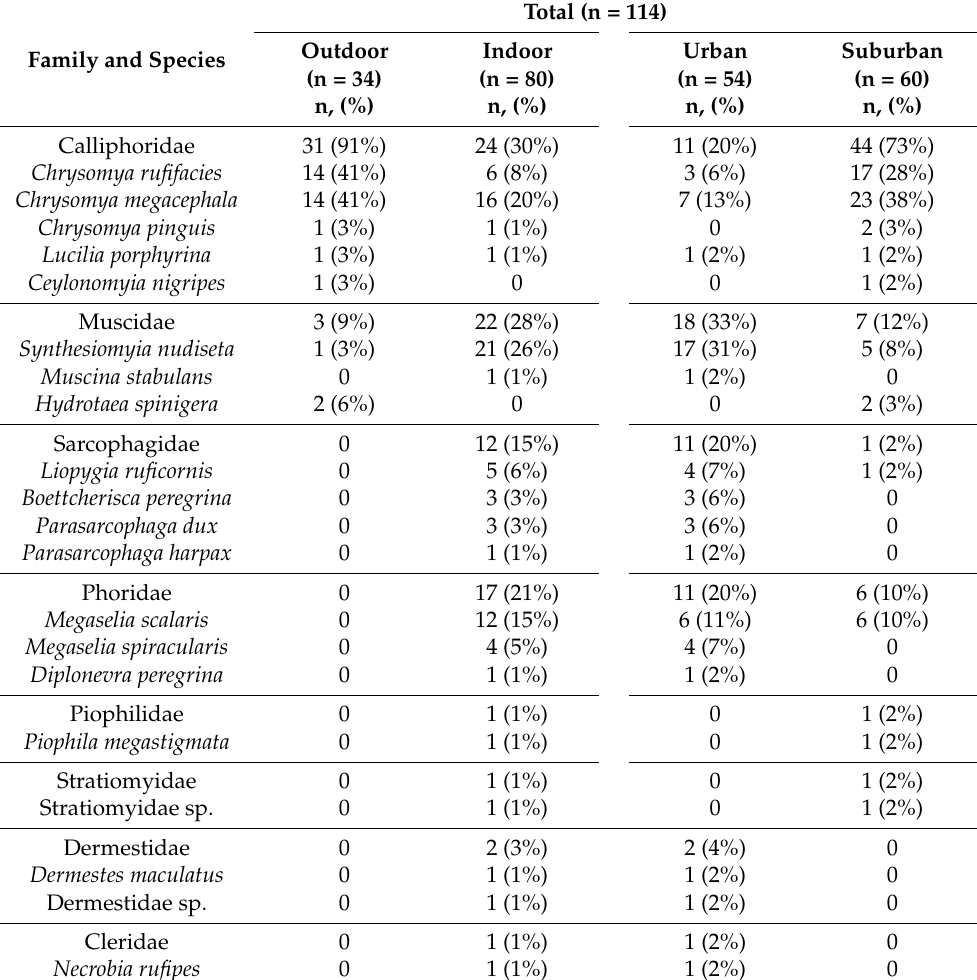
Table 4. Rate comparison of the predominant species collected from the 114 forensic cases in in- door/outdoor and urban/suburban cases in Taiwan from 2011 to 2018. (n, number of cases). Total (n = 114) Outdoor Indoor Urban Suburban Family and Species (n = 34) (n = 80) (n = 54) (n = 60) n, (%) n, (%) n, (%) n, (%) Calliphoridae 31 (91%) 24 (30%) 11 (20%) 44 (73%) Chrysomya rufifacies 14 (41%) Chrysomya megacephala 14 (41%)